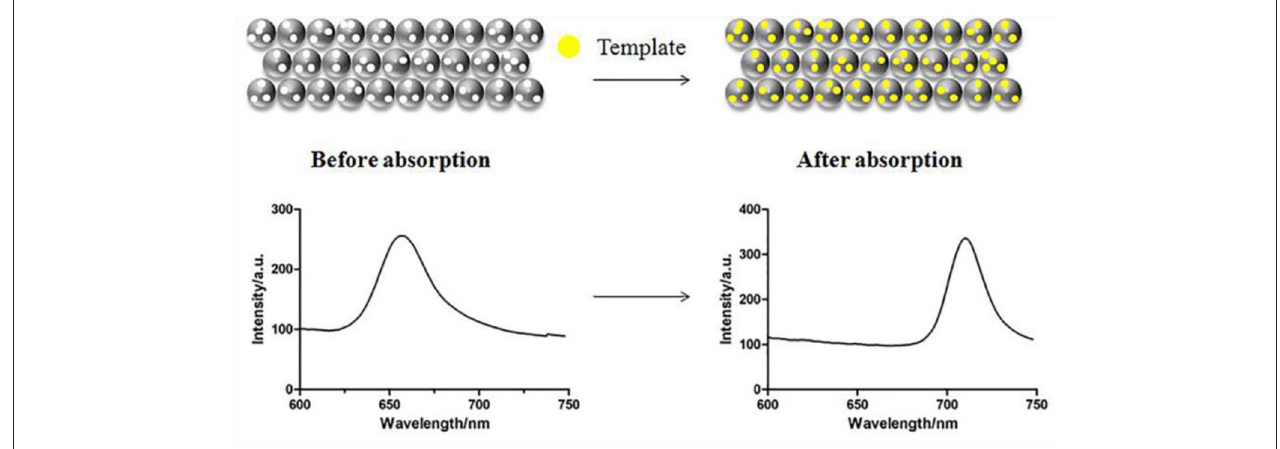
FIGURE 1 | The response mechanism of molecularly imprinted photonomic